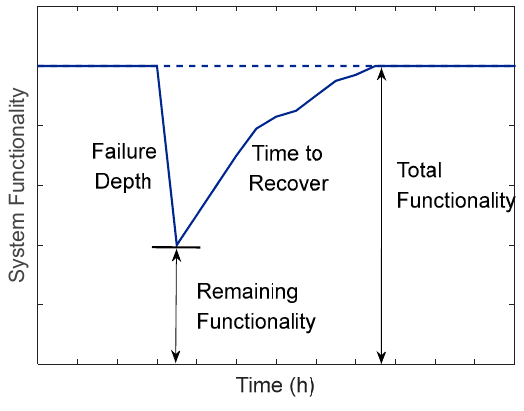
Figure 6. Concept of system resilience.